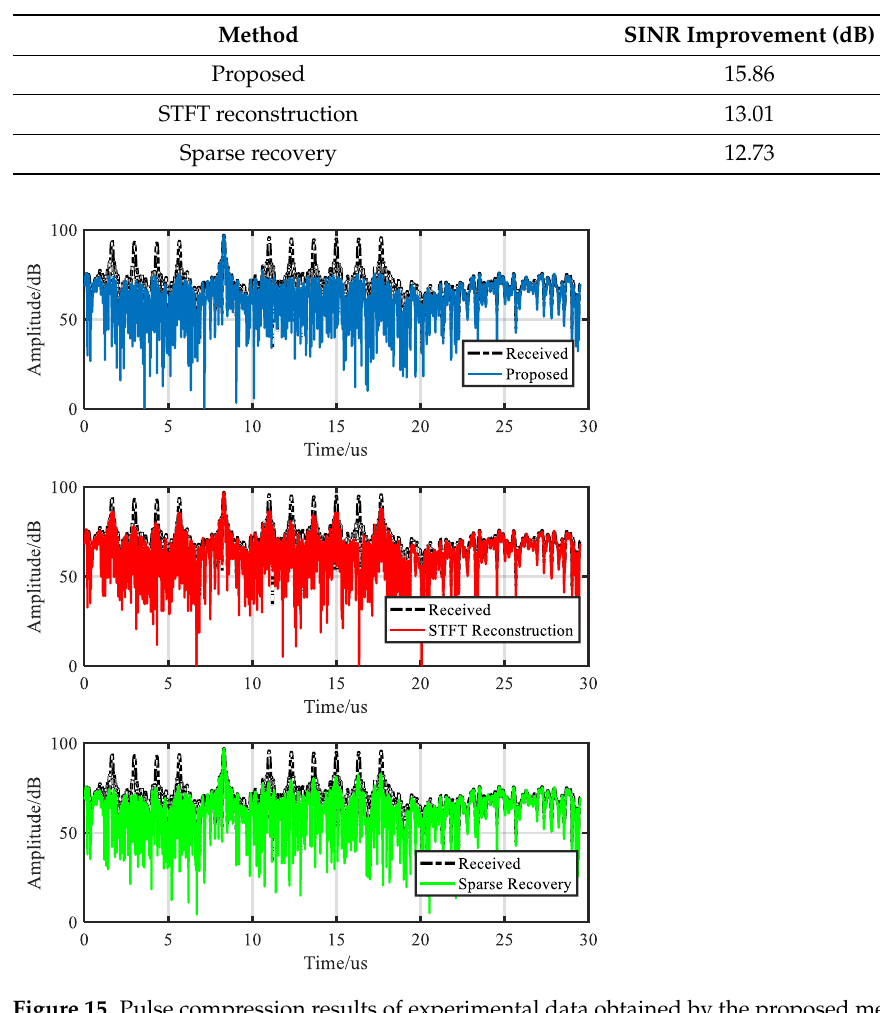
Figure 15. Pulse compression results of experimental data obtained by the proposed method, STFT reconstruction and Sparse recovery.